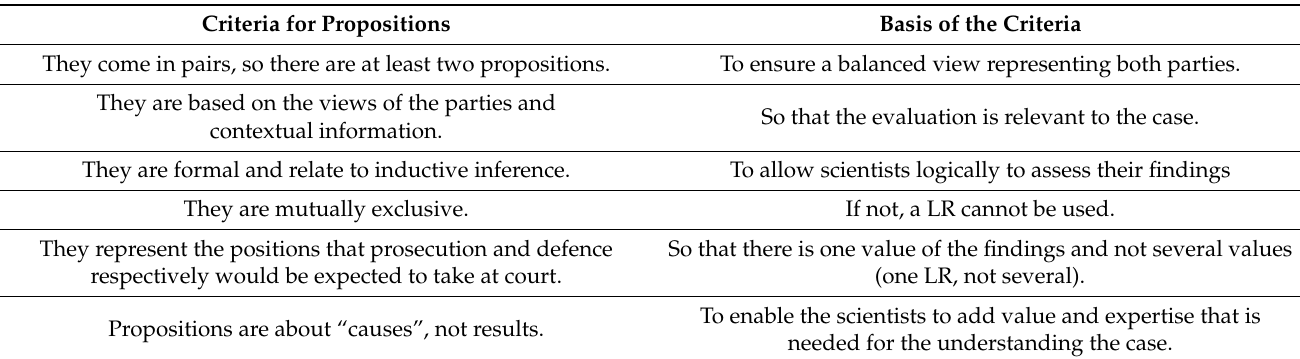
Table 5. Criteria that help spotting whether propositions are formulated in a meaningful